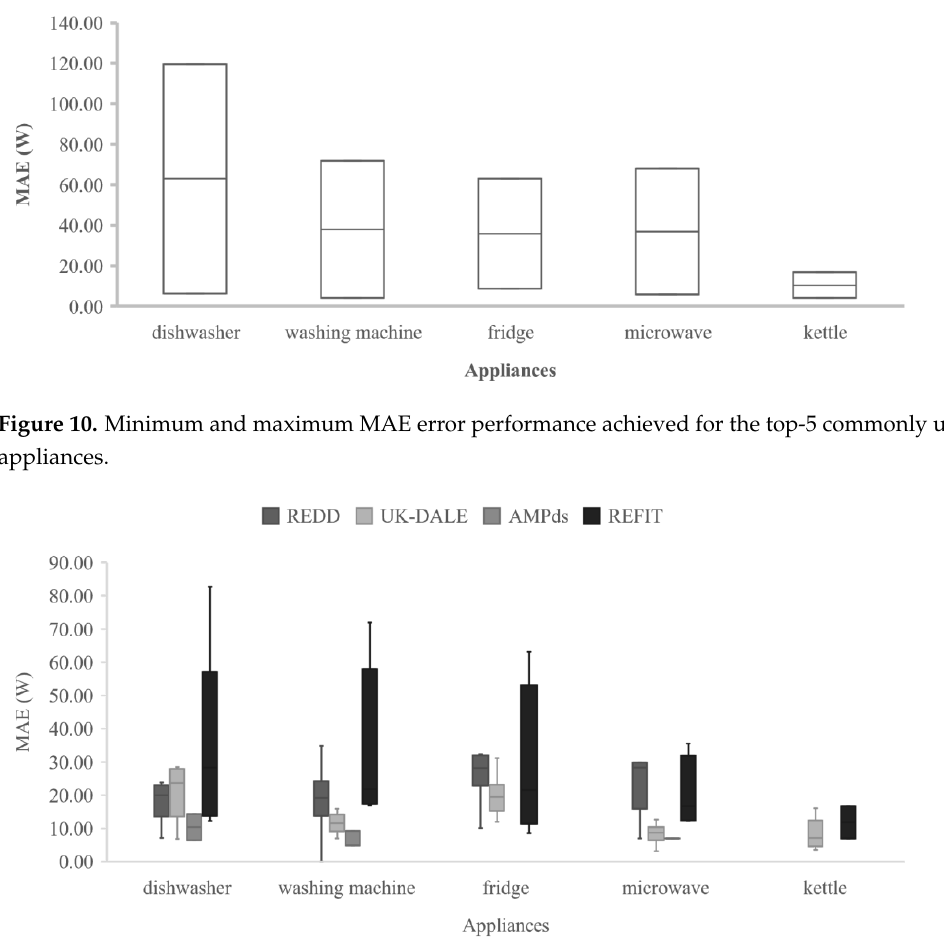
Figure 11. Minimum and maximum MAE error performance achieved for the top-5 commonly used appliances in the REDD, UK-DALE, AMPds, and REFIT